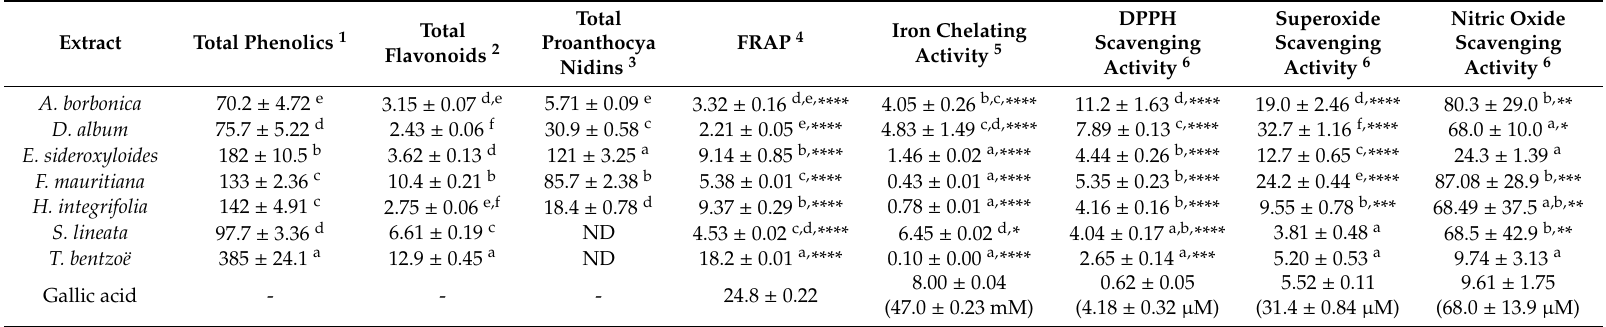
Table 2. Phenolic content and antioxidant potential of investigated leaf extracts.